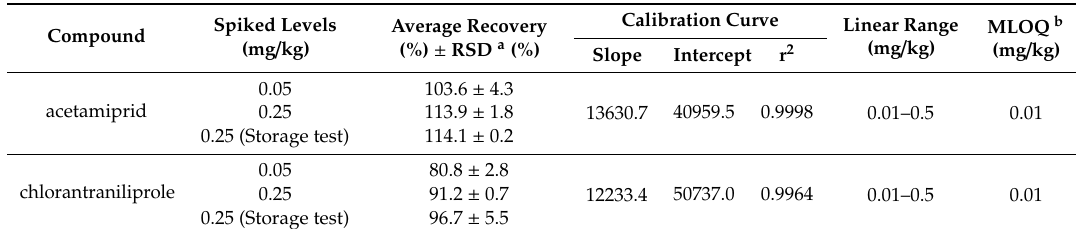
Table 2. Recovery results, linear regression parameters of calibration curve, limit of quantification (LOQ), and storage test in kimchi cabbage.